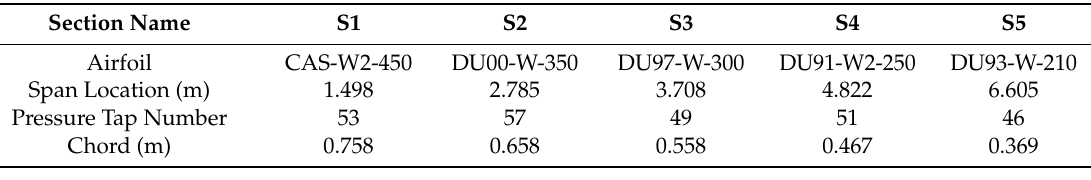
Table 6. Parameters of five pressure measurement sections.